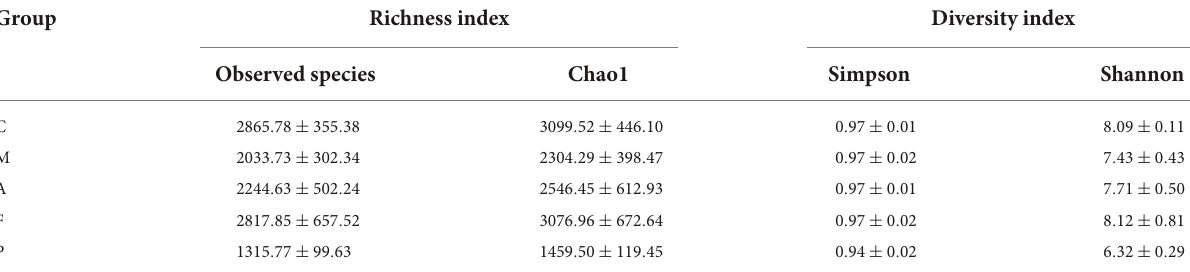
TABLE 2 The gut microbial diversity